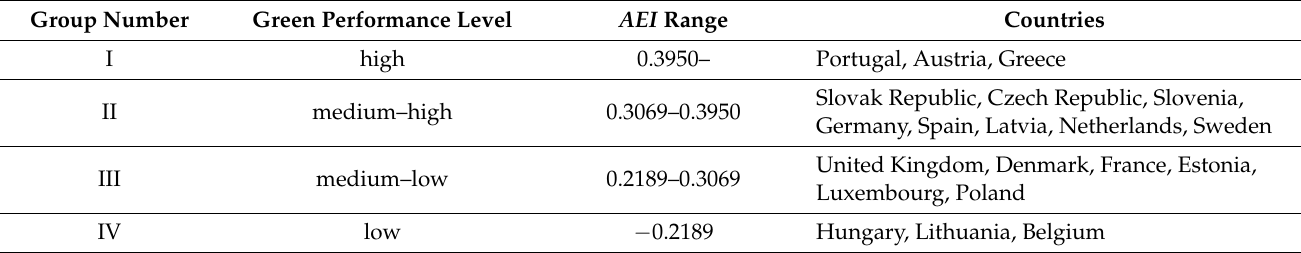
Table 2. Classification of 20 EU member states according to the value of the AEI . Group Number Green Performance